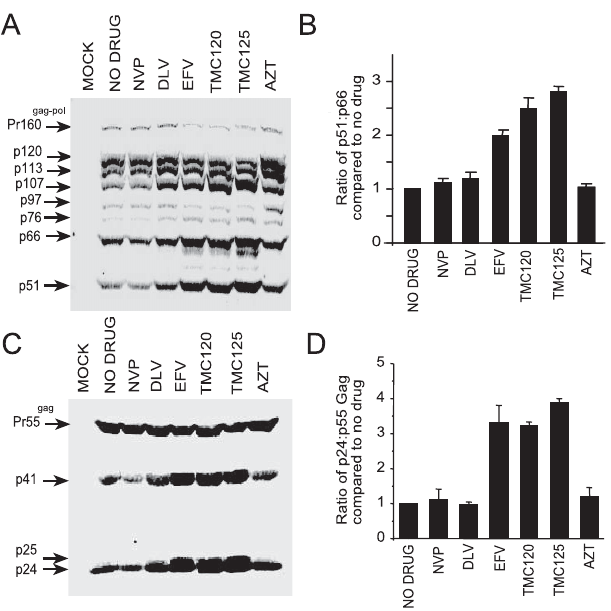
Figure 3. EFV, TMC120, and TMC125 Enhance Intracellular Gag and Gag- Pol Processing 293T cells were transfected with pDRNL and treated with 5 l M of each drug. After 36 h post-transfection, cell lysates were harvested and viral proteins were detected by quantitative Western blot analysis using (A) anti-RT and (C) anti-CA antibodies. AlexFluor680 goat anti-mouse was used as the secondary antibody. Western blots were scanned on an Odyssey Infrared Imager and analyzed using Odyssey software. Quantitation of the intracellular ratio of (B) p51 to p66 and (D) p24 to Pr55 Gag . The ratios were calculated from at least three independent experiments and are expressed as the mean 6 standard error.